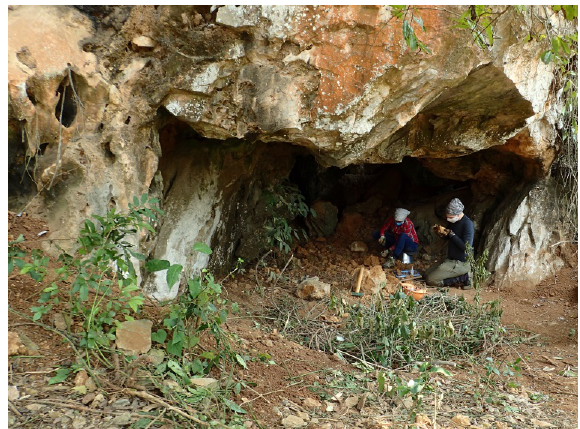
Figure 1. Excavations near the entrance to lower eastern galleries of LangTrank.